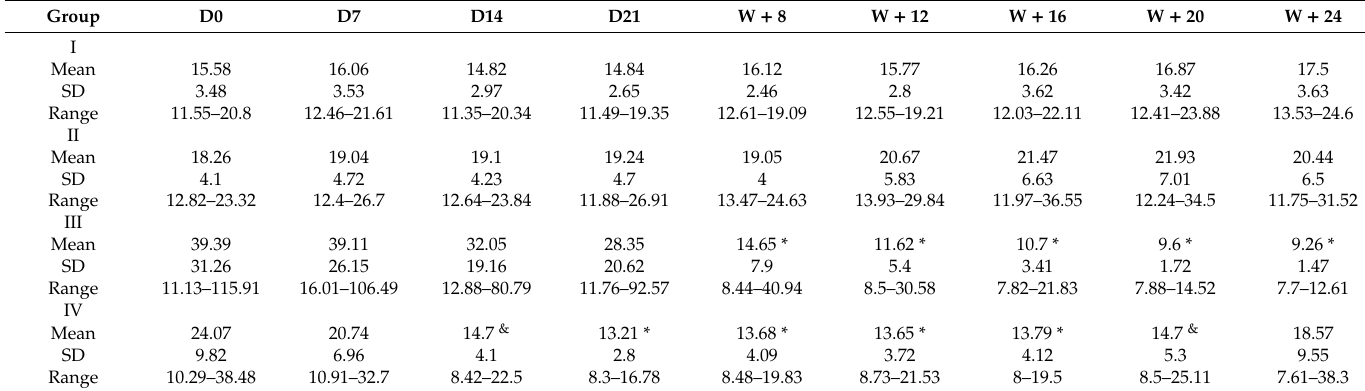
Table 2. Prostate volume (v, cm 3 ) in control I and II, and treated III and IV groups in the following examinations during the study period. Statistical analysis in